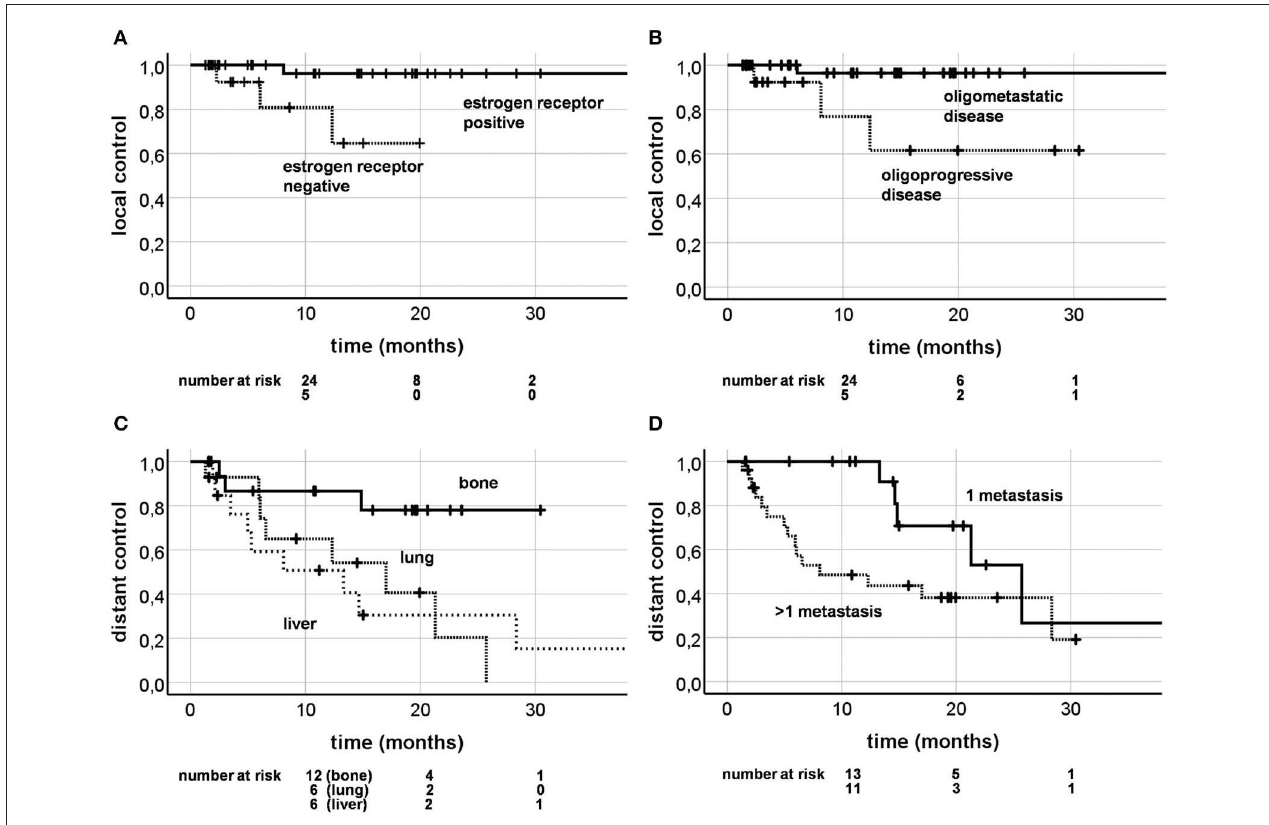
FIGURE 3 | Kaplan-Meier curves; local control depending on estrogen receptor positivity ( A ; p = 0.045) and oligoprogressive disease ( B ; p = 0.037); distant control depending on the irradiation site ( C ; p = 0.018) and present metastases ( D ; p = 0.056).